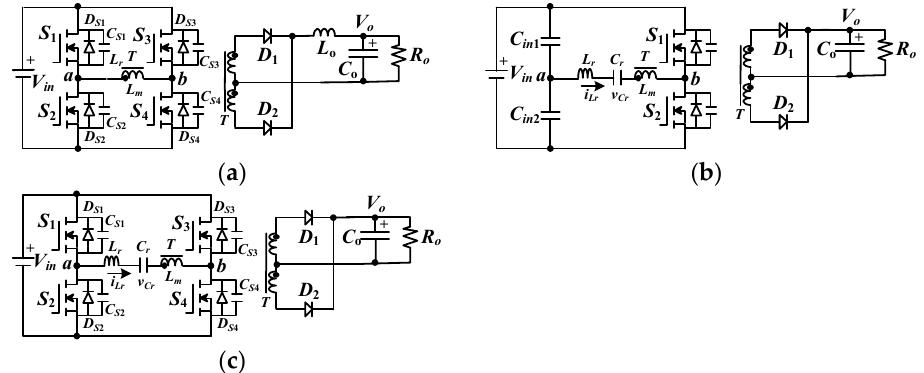
Figure 2. Possible circuit structures used in battery charger: ( a ) full bridge PWM converter, ( b ) half bridge resonant converter, ( c ) full bridge resonant converter.